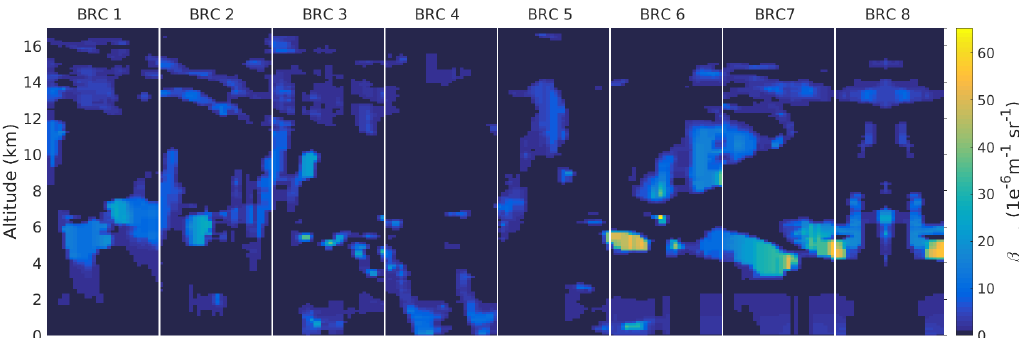
Figure 12. Particulate backscatter input for the E2S. The vertical white lines separate the BRCs.